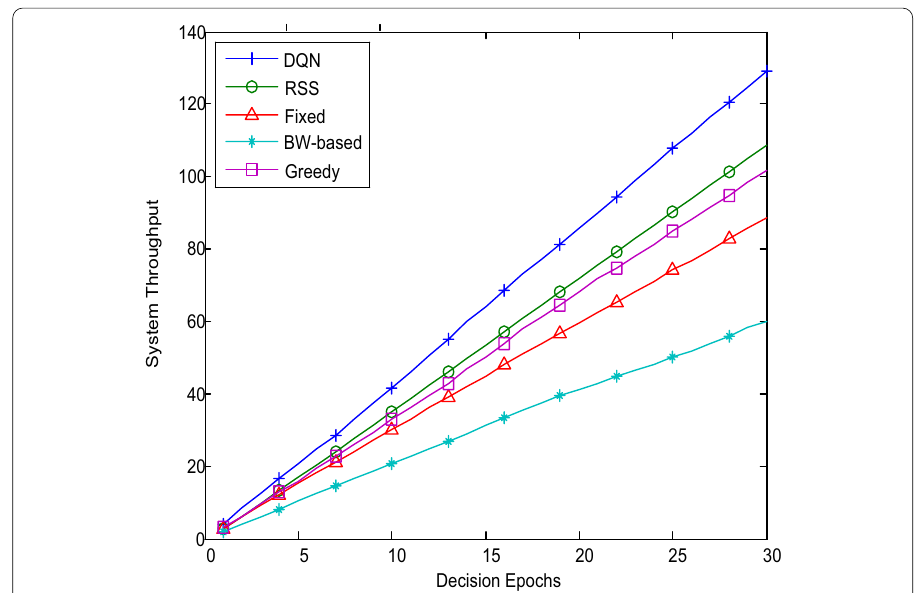
Fig. 5 Throughput. This figure shows the variation in system throughput as the number of decision steps increases. As shown in the figure, the DQN algorithm always achieves the highest throughput performance